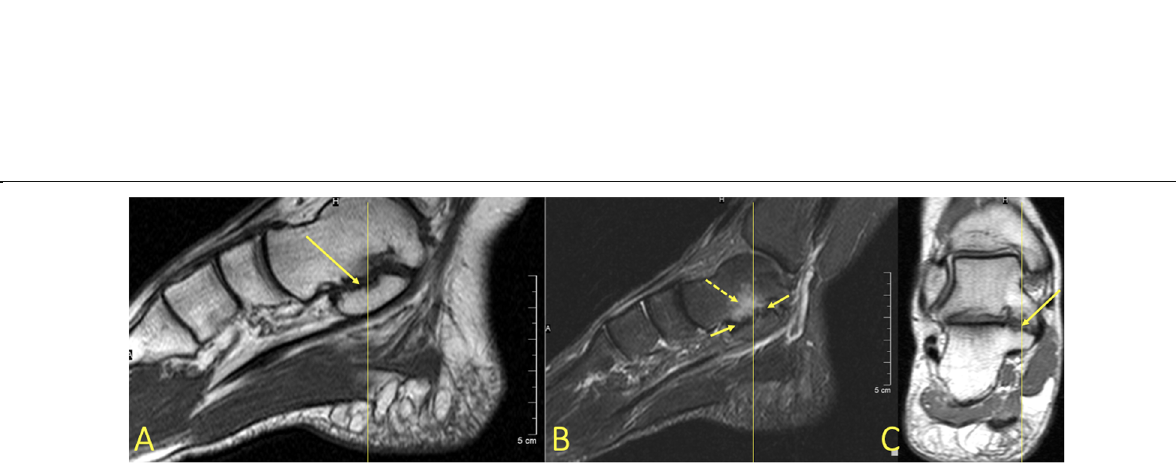
Fig. 23 A 43-year-old female with chronic ankle pain and suspicion of an osteochondral lesion and osteoarthritis. MRI showed a talocalcaneal coalition (arrow) with BME in the talus (dashed